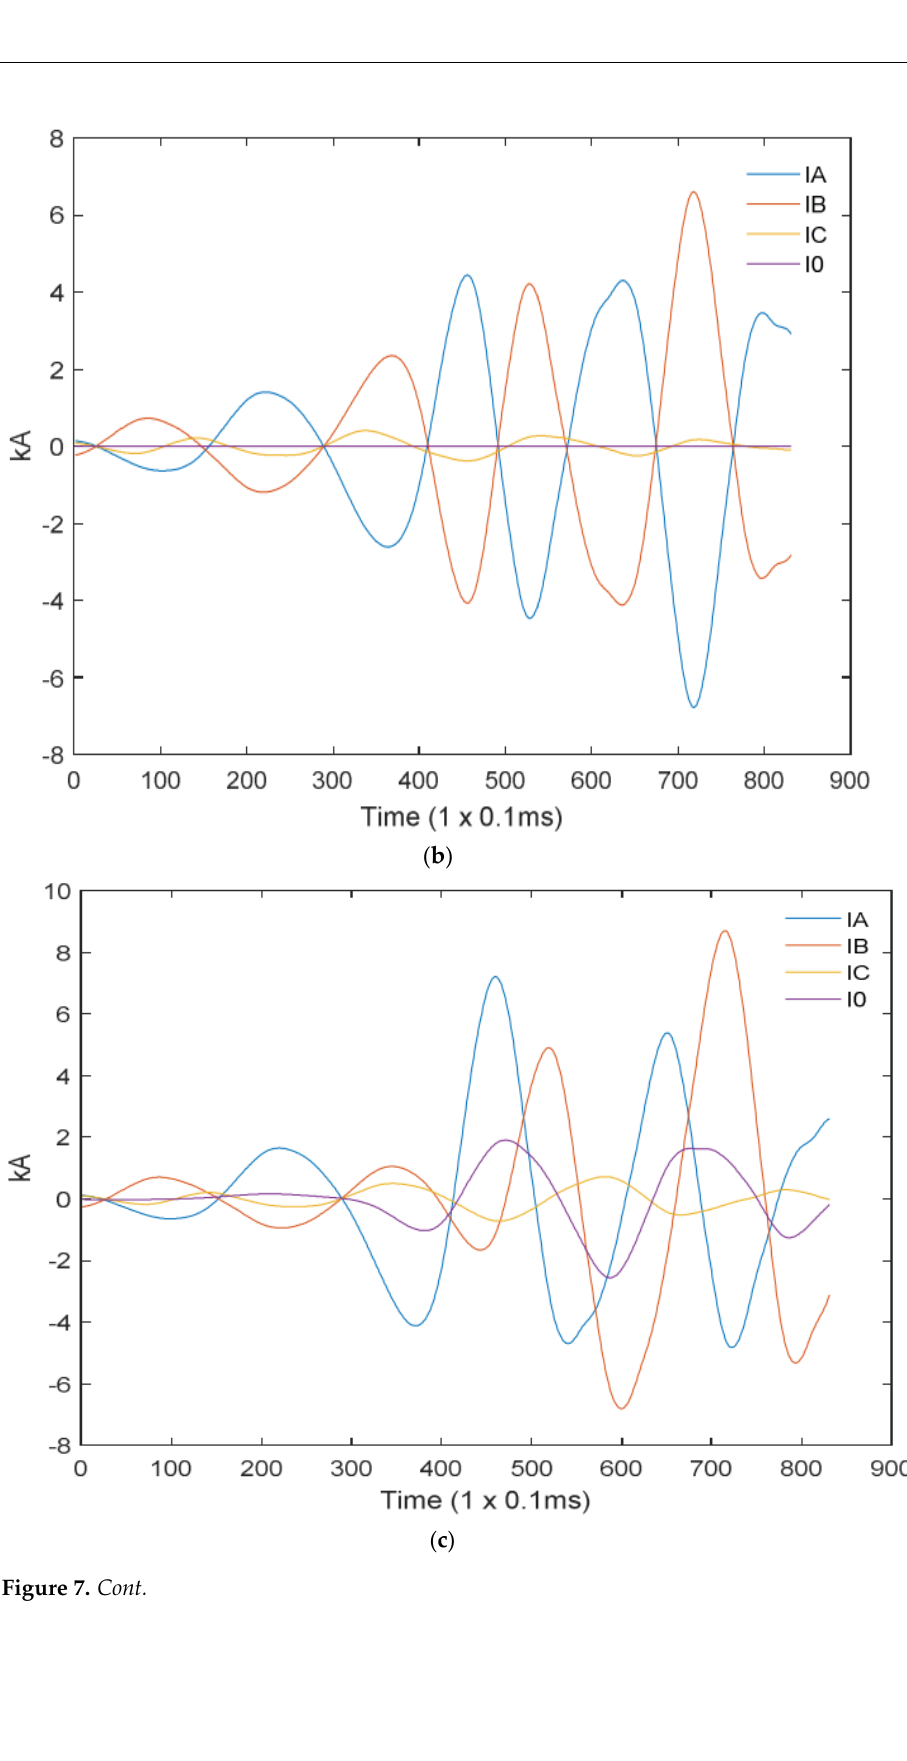
( d ) Figure 7. LG ( a ), LL ( b ), LLG ( c ), and LLLG ( d ) fault current signals.